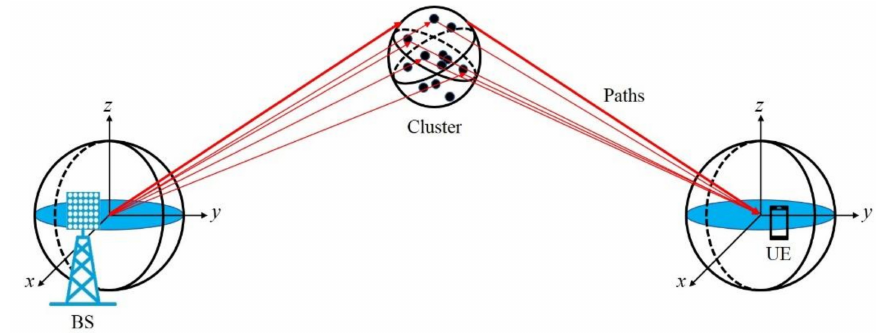
Figure 4. The 3D channel